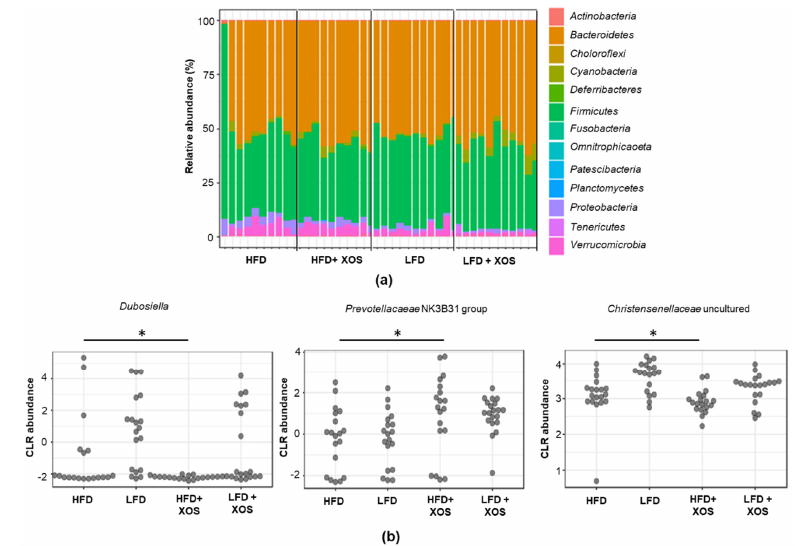
Figure 6. Differences were found in the abundance of three gut microbiota genera between the diet groups. ( a ) The gut microbiota composition of the rats at phylum level did not differ between the groups. n = 10/diet group. The taxonomic groups were compared based on DESeq2 using phyloseq R/Bioconductor package including Benjamini–Hochberg correction for multiple testing. ( b ) Differences between the groups were found in the relative abundance of Dubosiella , Prevotellaceae NK3B31 and uncultured genus of Christensenellaceae family. n = 10/diet group. The taxonomic groups were compared based on DESeq2 using phyloseq R/Bioconductor package including Benjamini–Hochberg correction for multiple testing. CLR abundance = centered log-ratio transformed abundance. * indicates statistically significant difference between the groups.